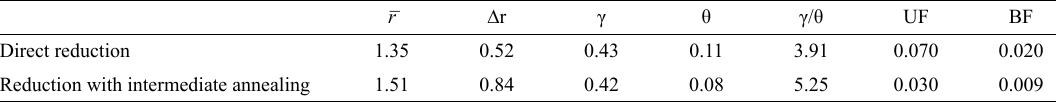
Table 1. Coefficient of anisotropy and texture after the final annealing